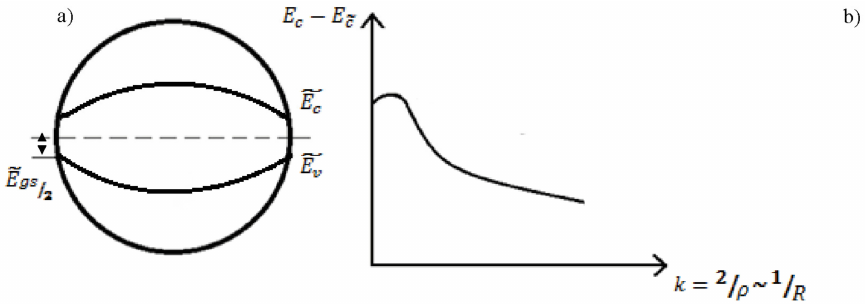
Figure 9. Schematic representation of the energy level of an impurity of a spherical nanoparticle ( a ) and the dependence of its energy on the surface curvature R in a two-zone model ( b